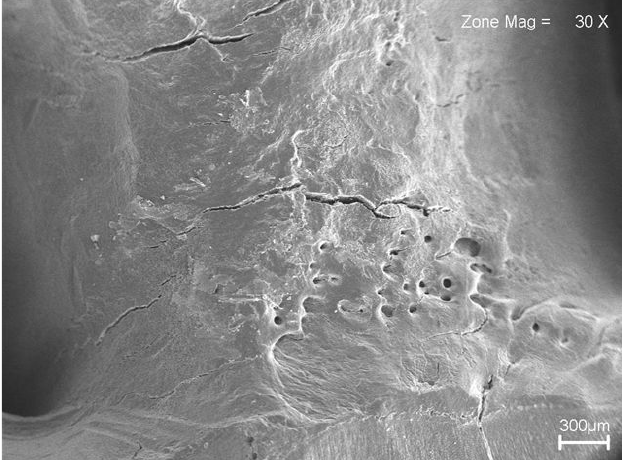
Fig. 1. SEM micrograph of foramina in the pulp chamber floor (Original magnification x30).